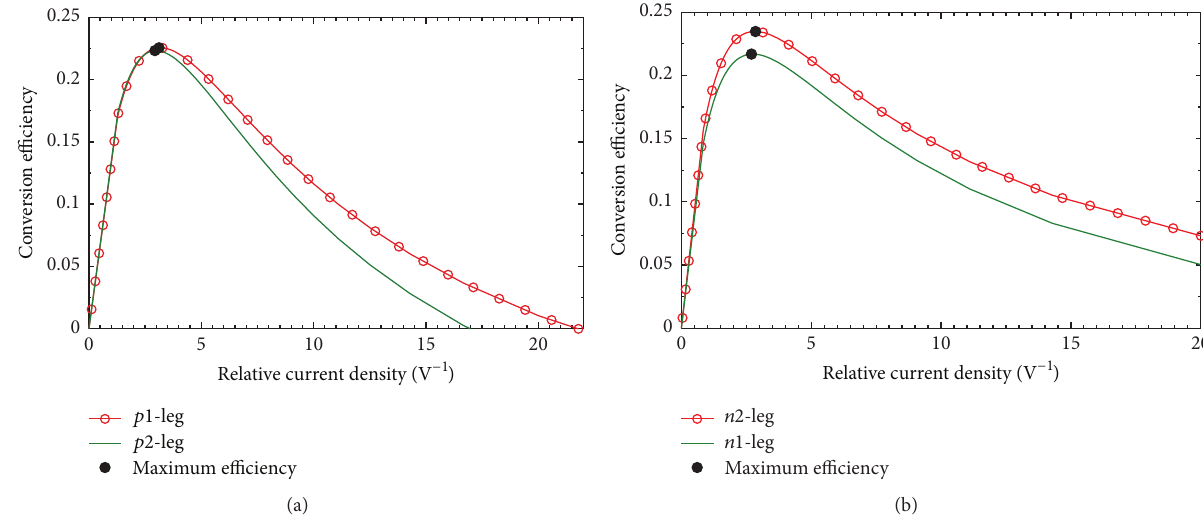
Figure 3: Variation of conversion efficiency versus 𝑢(𝑇 ℎ ) (relative current density at 𝑇 ℎ ) for (a) 𝑝 1-leg and 𝑝 2-leg and (b) 𝑛 1-leg and 𝑛